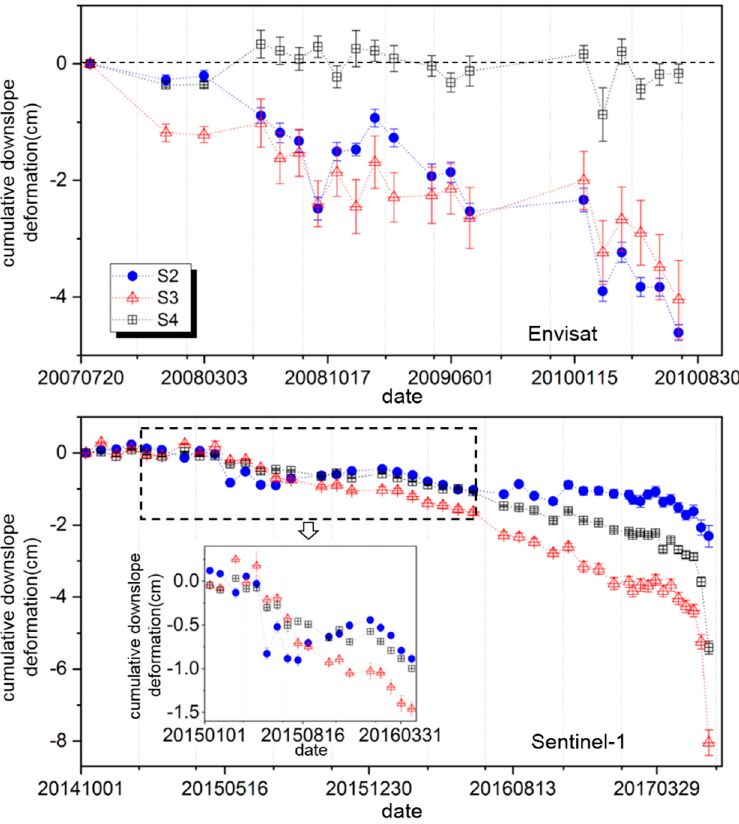
Figure 10. Time series deformation of the S2, S3 and S4 regions from Envisat data ( upper panel ) and Sentinel-1 data ( lower panel ). The extents of S2, S3 and S4 regions are shown in Figure 3d.